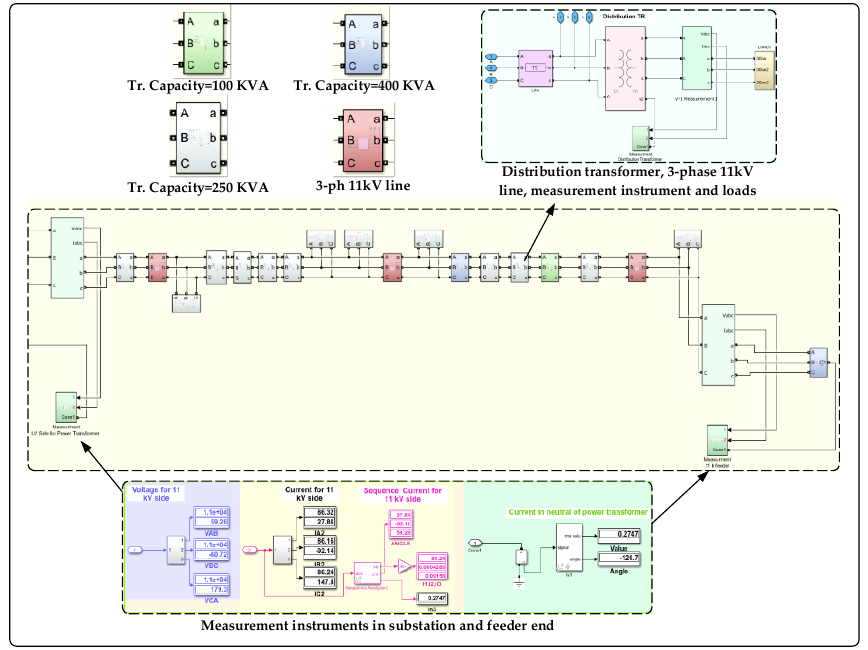
Figure 9. Implement the LSBC fault on the distribution feeder.